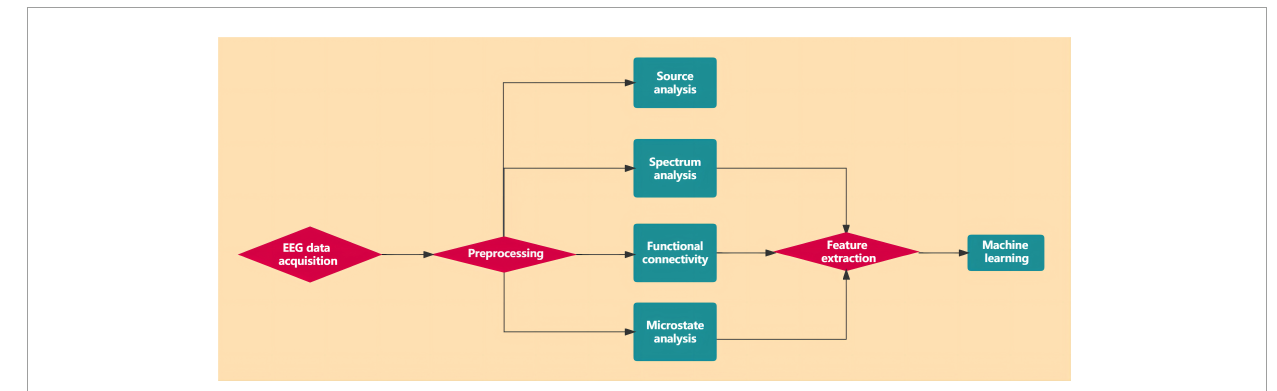
FIGURE5 The flow chart of the EEG data analysis.